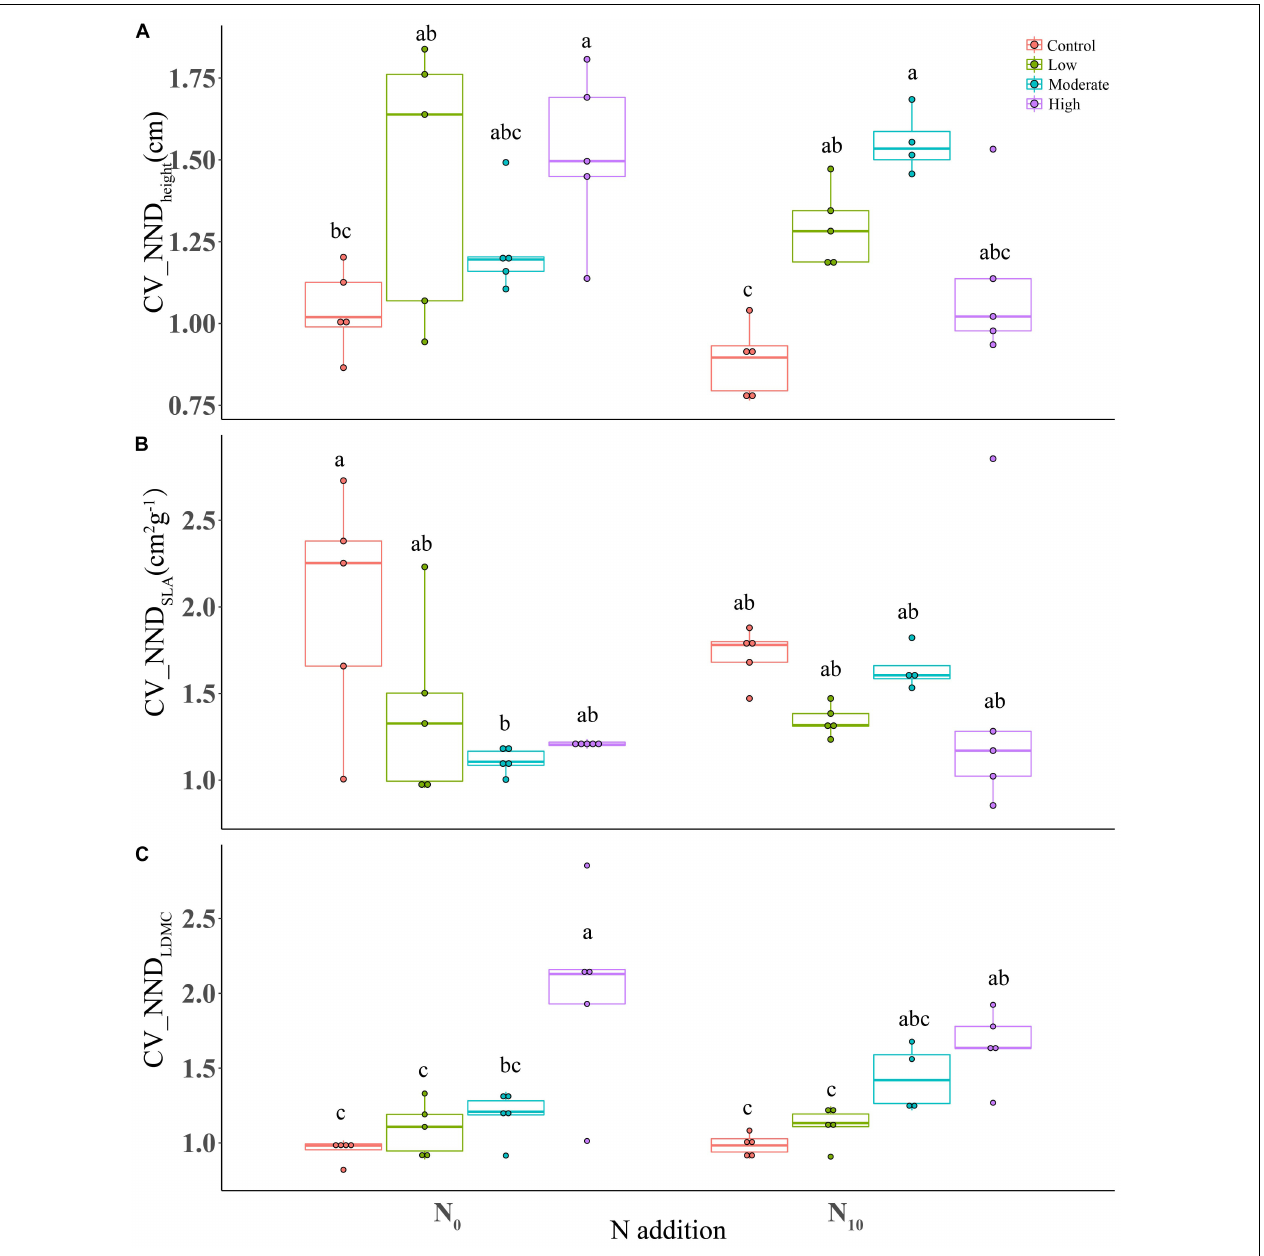
FIGURE 4 | Boxplots showing the differences in CV_NND of functional traits among fertilization (N 0 : control, N 10 : nitrogen addition) and clipping (i.e., control, low intensity, moderate intensity, high intensity) treatments. (A) height, (B) specific leaf area, and (C) leaf dry matter content. CV_NND, coefficient of variation of nearest neighbor distance. The box signifies the upper and lower quartiles, and the whiskers extend up to 1.5 times that intra-quartile range. Median is represented by horizontal line. For a given trait, different letters between treatments donate significant differences ( P < 0.05, Tukey’s HSD